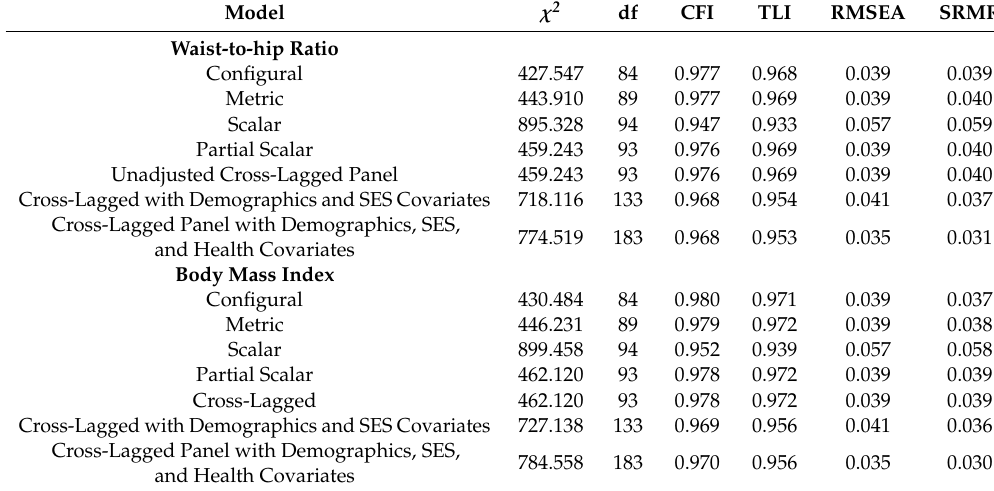
Table 2. Measurement invariance fit indices in waist-to-hip ratio and body mass index (BMI) across two waves.